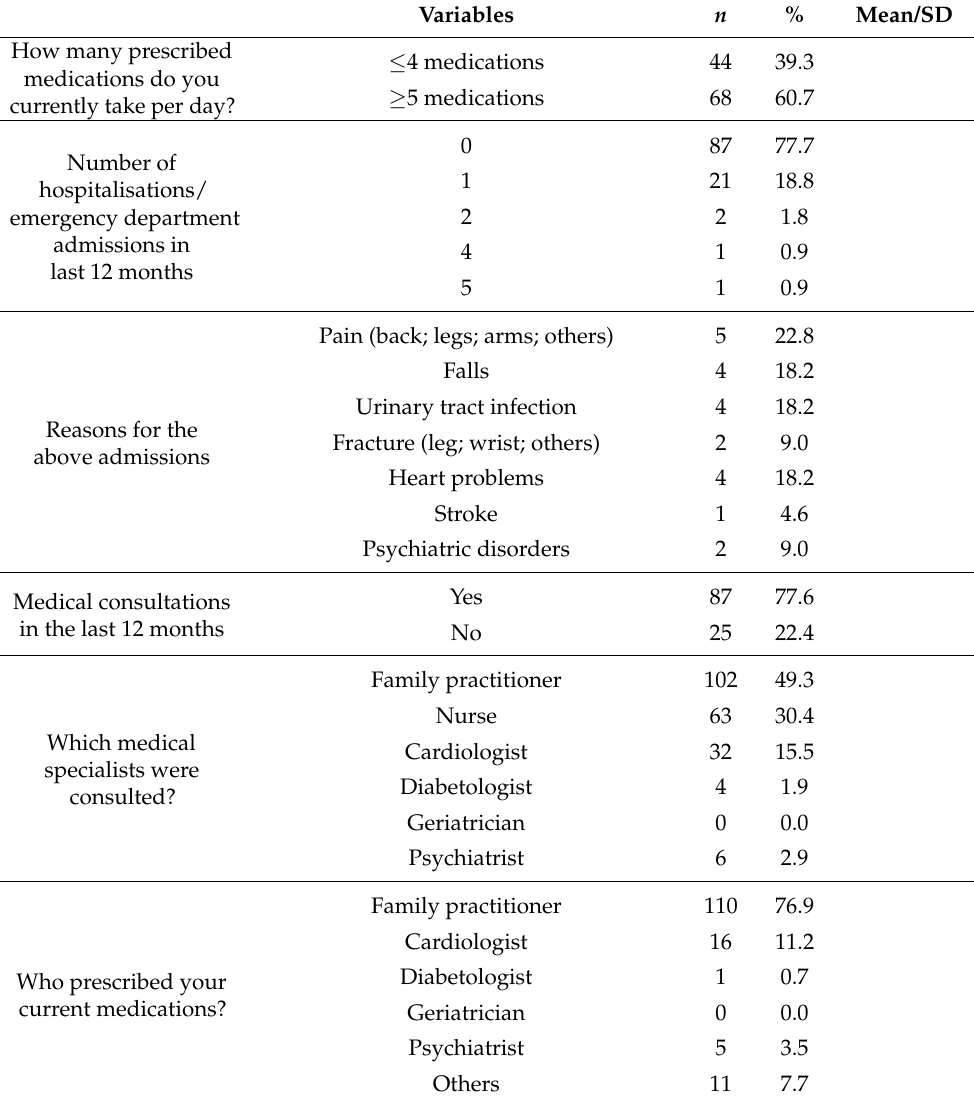
Table 2. Participants’ medication management, medical conditions and TFI-P subscale B results determined in the structured interviews ( n = 112). Variables n %